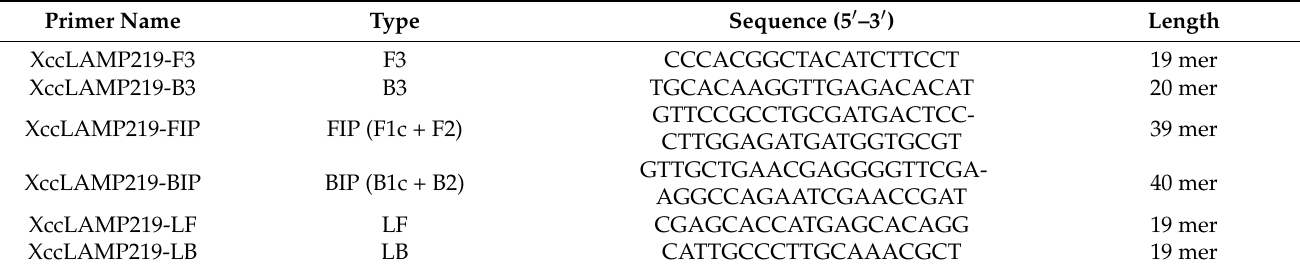
Table 1. LAMP primers designed on X. citri pv. citri unique